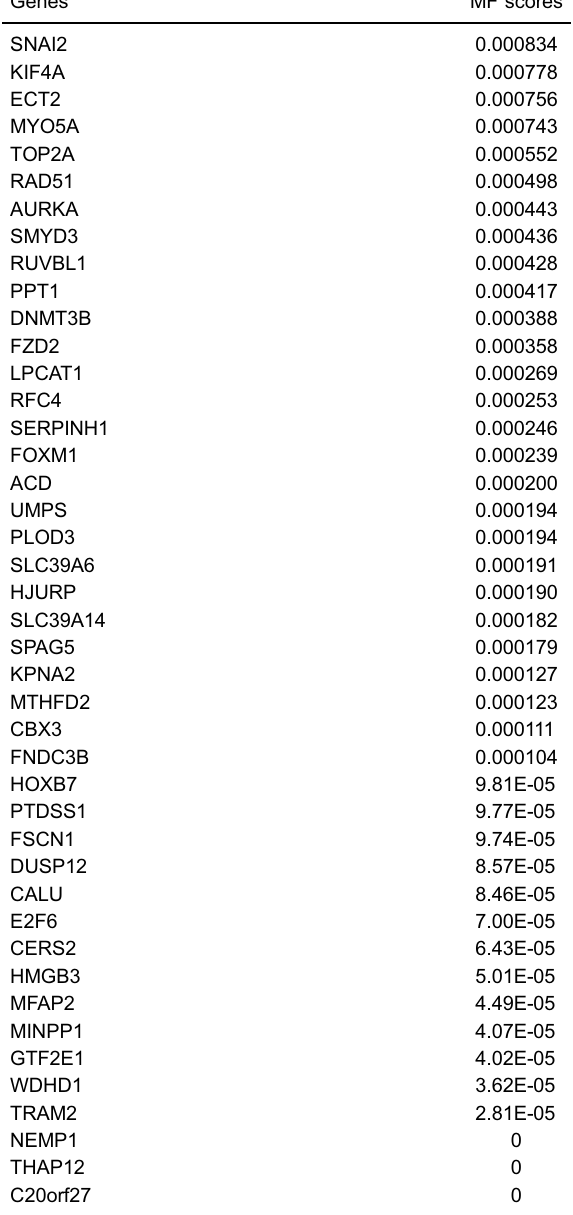
Table 2. Distribution of multifunctionality (MF) score of differen- tially expressed genes.